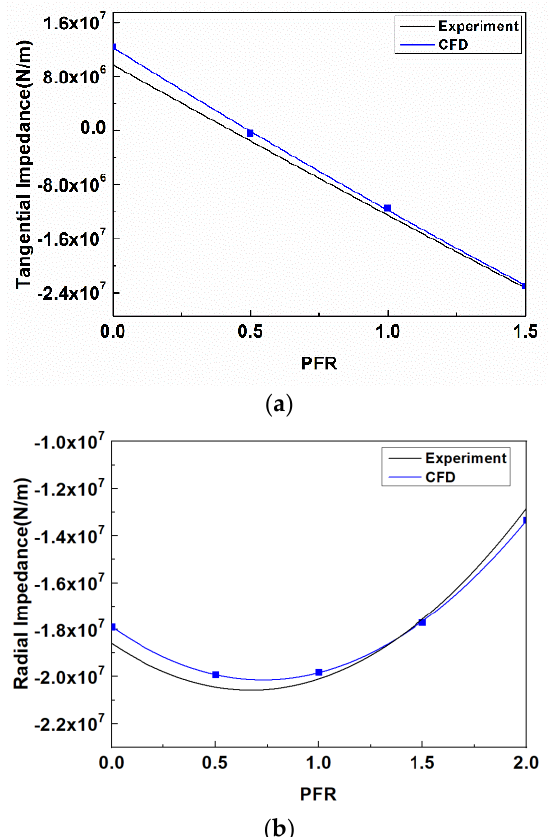
Figure 7. Response force on the rotor (PFR = 1).